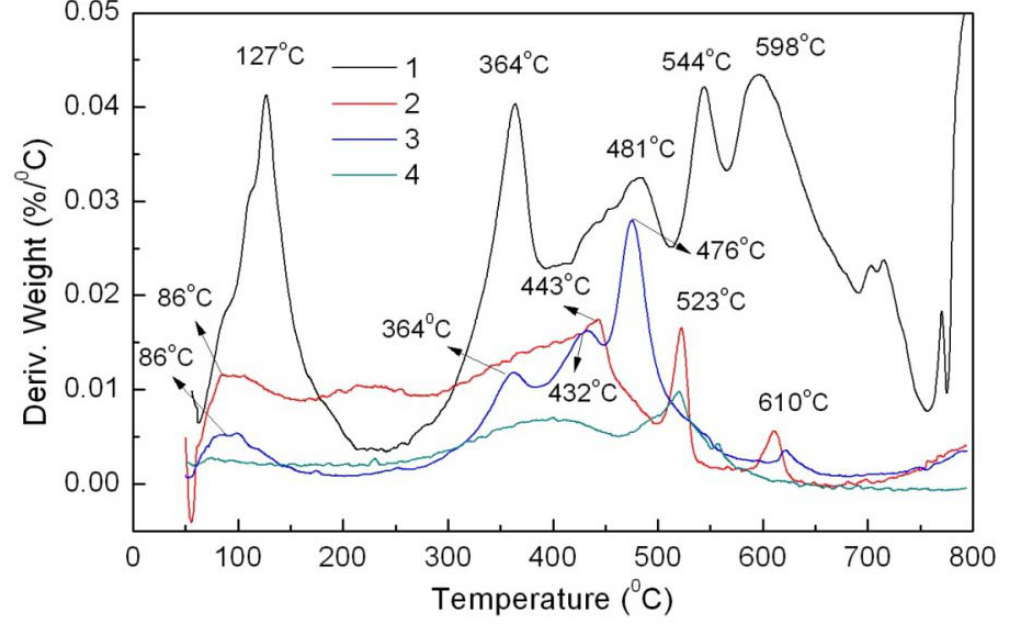
Figure 6. DTG curves of powder MB ( 1 ), the BaSO mixture ( 3 ), and BaSO